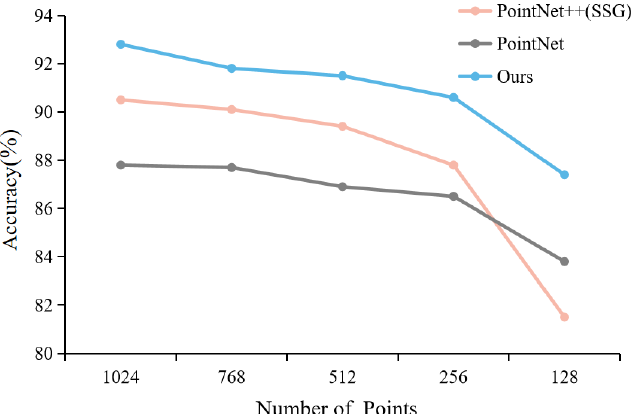
Figure 6. Classification accuracy of our model and other models with different numbers of input points on ModelNet40